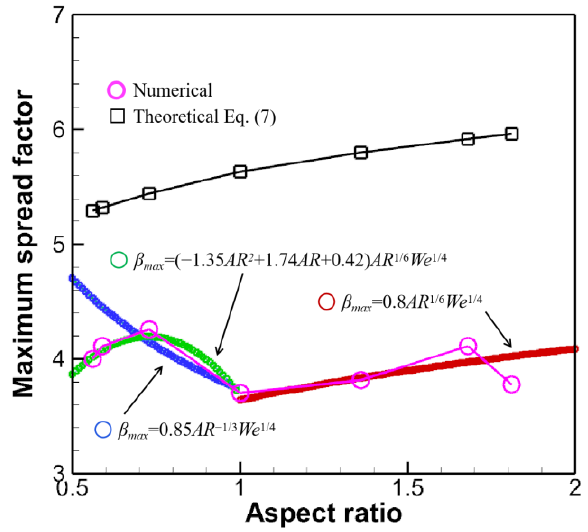
Figure 21. Maximum spread factors for different ARs. The oblate droplet impact corresponds to those ARs smaller than unity, while the prolate droplet impact to those larger than unity.